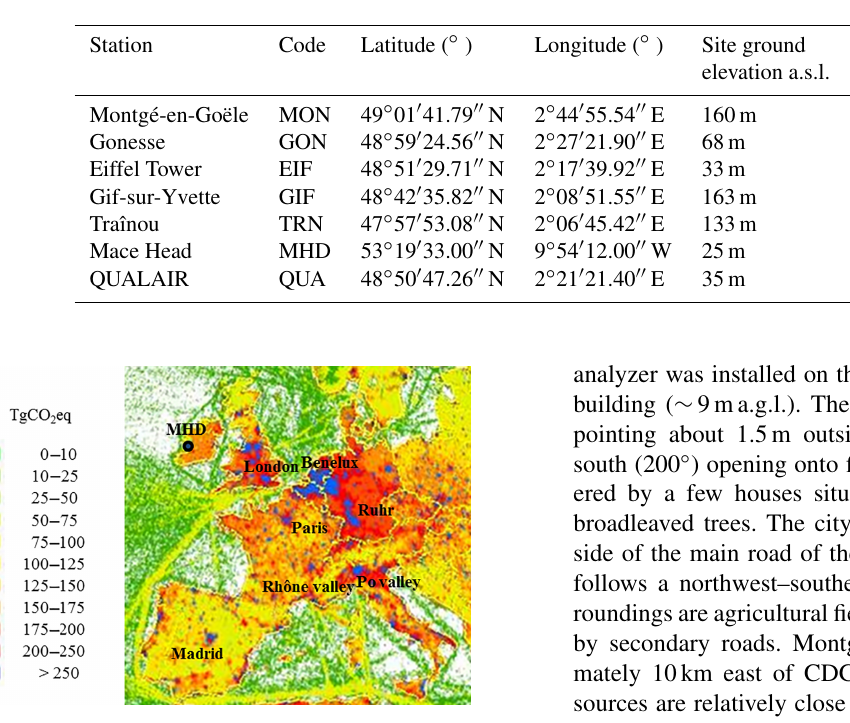
Table 1. Coordinates of the stations used in this study (a.s.l. stands for above sea level; a.g.l. for above ground level).